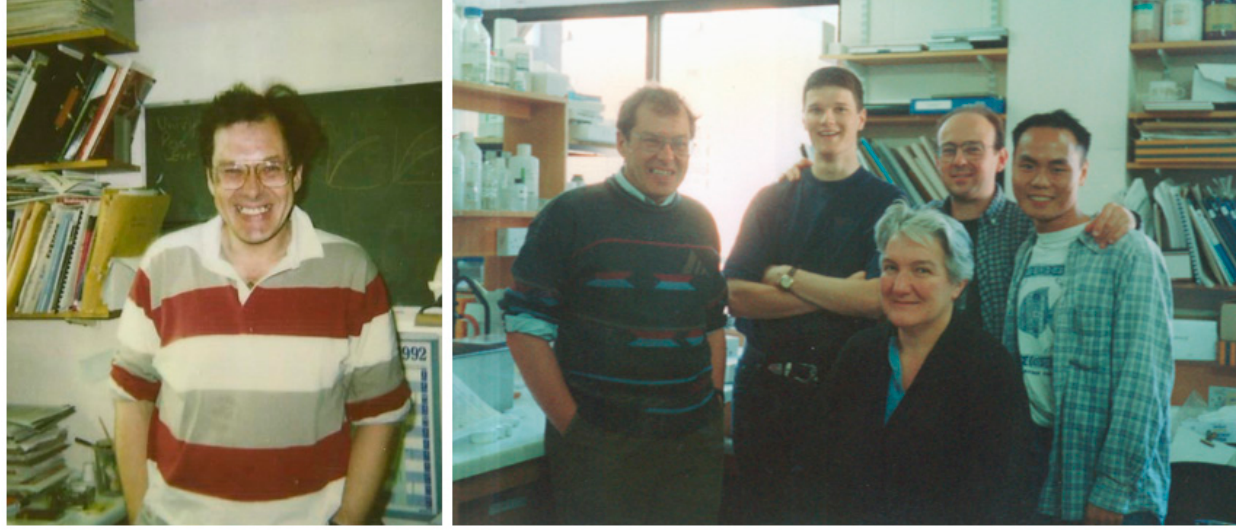
Figure 1. Bob in his office ( left ) and in the lab ( right ) ca. 1996. In the right-hand photograph, from left to right: Bob, Guy Stuart (D.Phil. student), Beryl Moffatt, the author, and Niki Wong (D.Phil. student); Bing Bin Yu and Timothy Hickling (not in the picture) were also D.Phil. students in the group at the time.